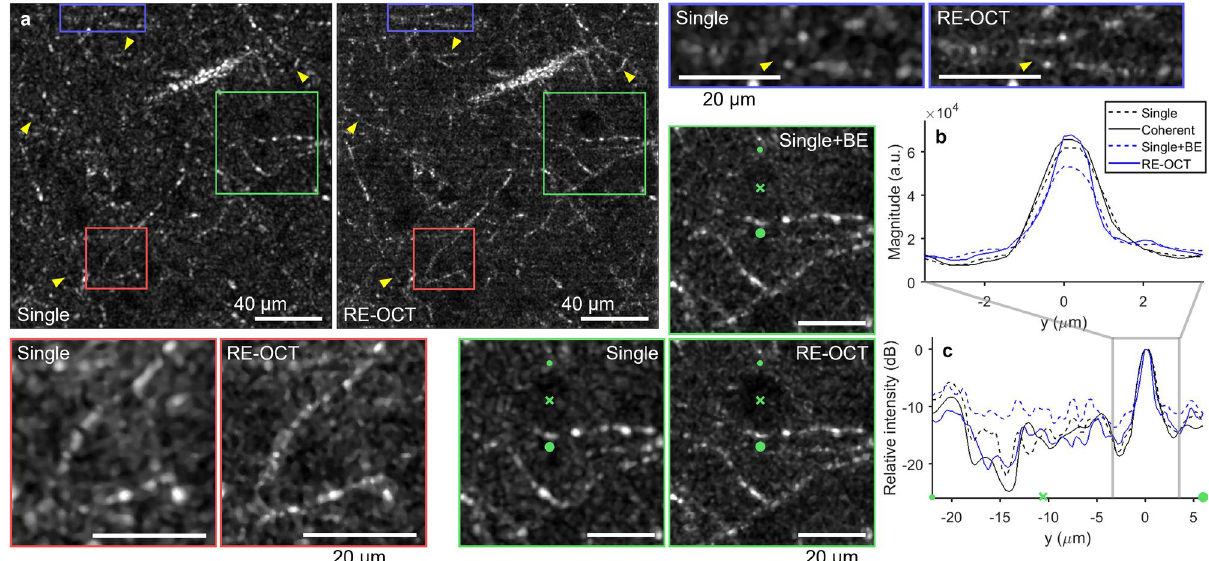
Figure 5. RE-OCT with 100 acquisitions and ×2.0 BE in the cortex of ex vivo mouse brain. ( a ) Single-shot and RE-OCT en face OCT images with zoomed insets regions indicated by boxes. Images were taken in the first cortical layer at approximately 100 µm below surface. Yellow arrows indicate myelinated axonal processes that can be more clearly visualized with RE-OCT. × markers in the green zoomed insets indicate one of the neurons, which appear as darker circles due to weak OCT scattering. Green inset shows that neuron in BE single-shot image was barely discernible due to the SNR penalty without coherent-average noise suppression. Scale bars, 40 µm (full) and 20 µm (zoomed). ( b , c ) Cross-sectional profiles of a line connecting from small to large green dots in the green zoomed insets in ( a ) on linear and peak-normalized log scales. The green × marker indicates its corresponding position on the image. See Supplementary Movie 3 for a movie of ( a – c ) as increasing BE factor is